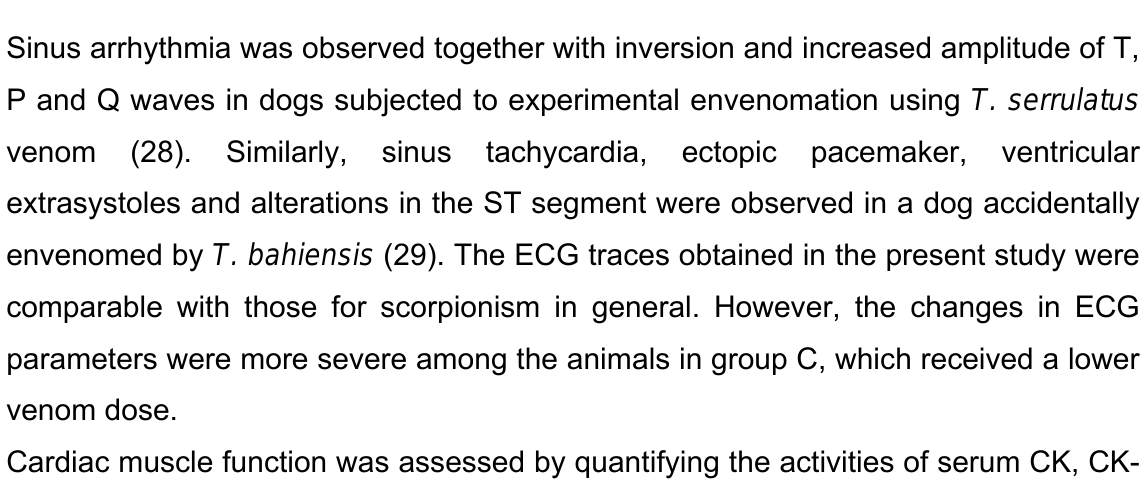
Figure 2. Electrocardiographic traces of animals in group C, which were subjected to experimental envenomation using Tityus serrulatus venom; ( A ) bradycardia at 25 minutes and inverted P wave (arrowed), and ( B ) accentuated bradycardia at 30 minutes. Speed of 25 mm/s and sensitivity of